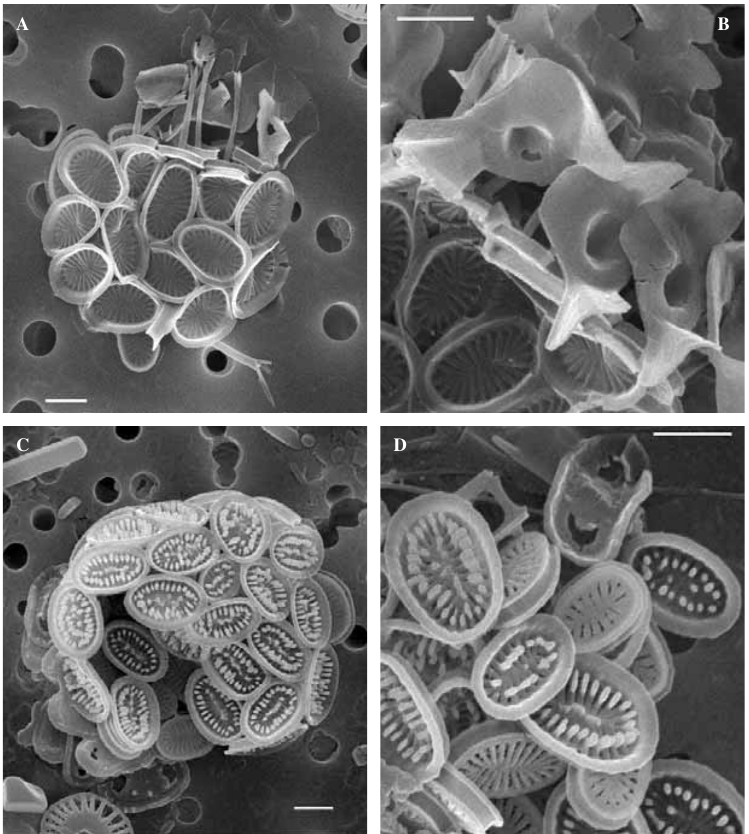
F IG . 33. – A-B, Syracosphaera sp. (slender): A , coccosphere with body caneoliths, circum-flagellar caneoliths with long and slender spines, some complex undulating exothecal coccoliths around the apical pole and one antapical caneolith with a long spine [Fronts-96, 013, 60 m]; B , detail showing some body endothecal caneoliths (lower left), exothecal coccoliths positioned around the flagellar area, and, partially hidden, some circum-flagellar caneoliths with long spines tipped by four small wings [Fans-1, 123, 40 m]. C-D, Syracosphaera sp. (laths with rod protusions): C , coccosphere showing body cane- oliths with the rods distributed in a more or less regular pattern and several simple undulating exothecal coccoliths (lower left), mostly detached [Hivern-99, 25, 60 m]; D , detail showing one simple undulating exothecal coccolith with two paren- thesis-like large slits around the central area and several endothecal caneoliths [Fans-1, 123, 60 m]. Scale bars = 1